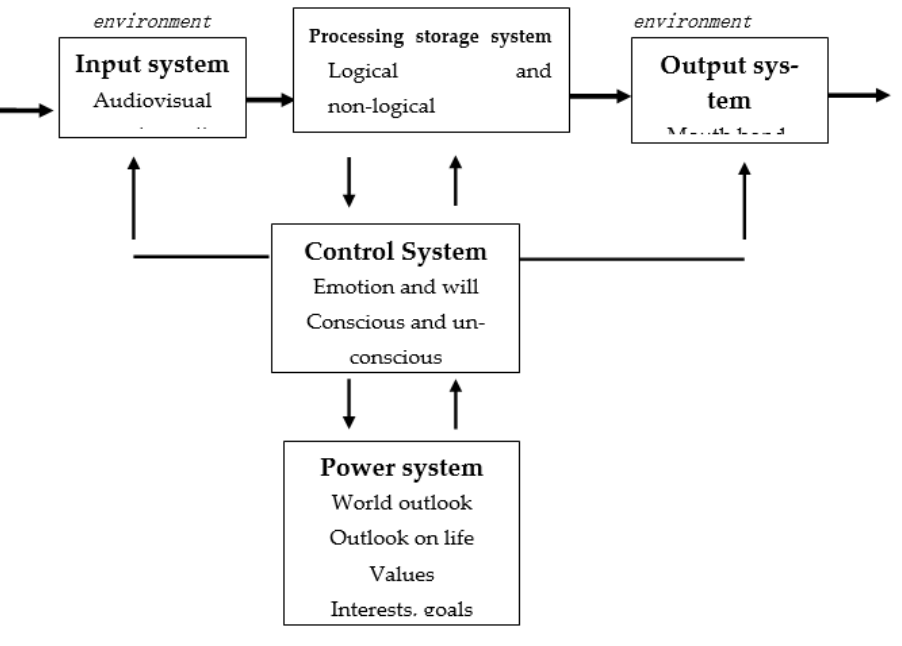
Figure 1. Human intelligence system model.